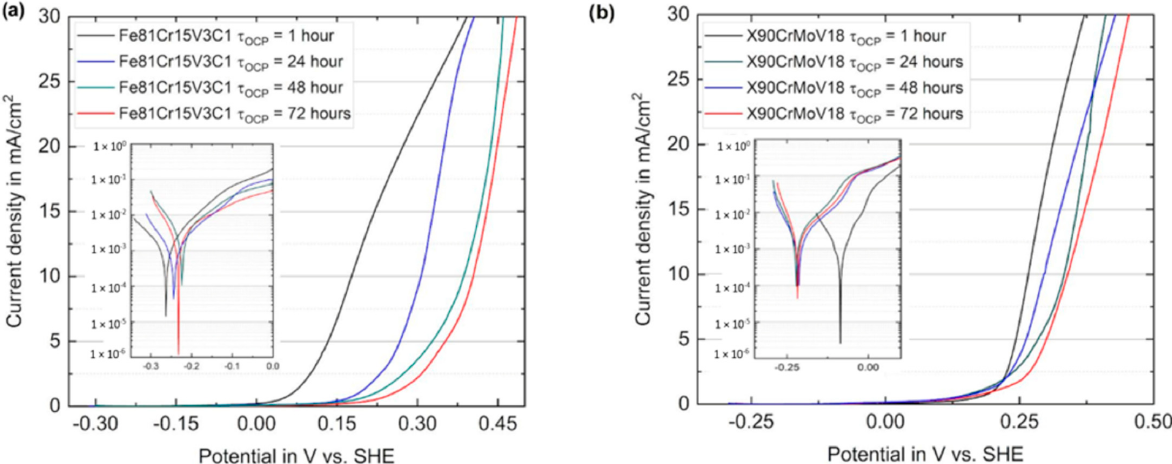
Figure 8. Representative potentiodynamic polarization curves for ( a ) the novel cast steel Fe81Cr15V3C1 and ( b ) the reference steel X90CrMoV18, measured in 3.5 wt.% NaCl solution at room temperature after different immersion times at OCP (insets: semi-logarithmic plot of the Tafel regions near to E corr ). Table 4. Summary of electrochemical corrosion data (mean values of repeated tests) for Fe81Cr15V3C1 and X90CrMoV18 extracted from polarization curves recorded after different immersion times (t) at OCP, exemplified as shown in Figure 8: (corrosion potential (E corr ), corrosion current density (I corr ), anodic Tafel slope (b a ), cathodic Tafel slope (b c ), polarization resistance (R p ), pitting potential (E pit ), and passive region (E pit -E corr